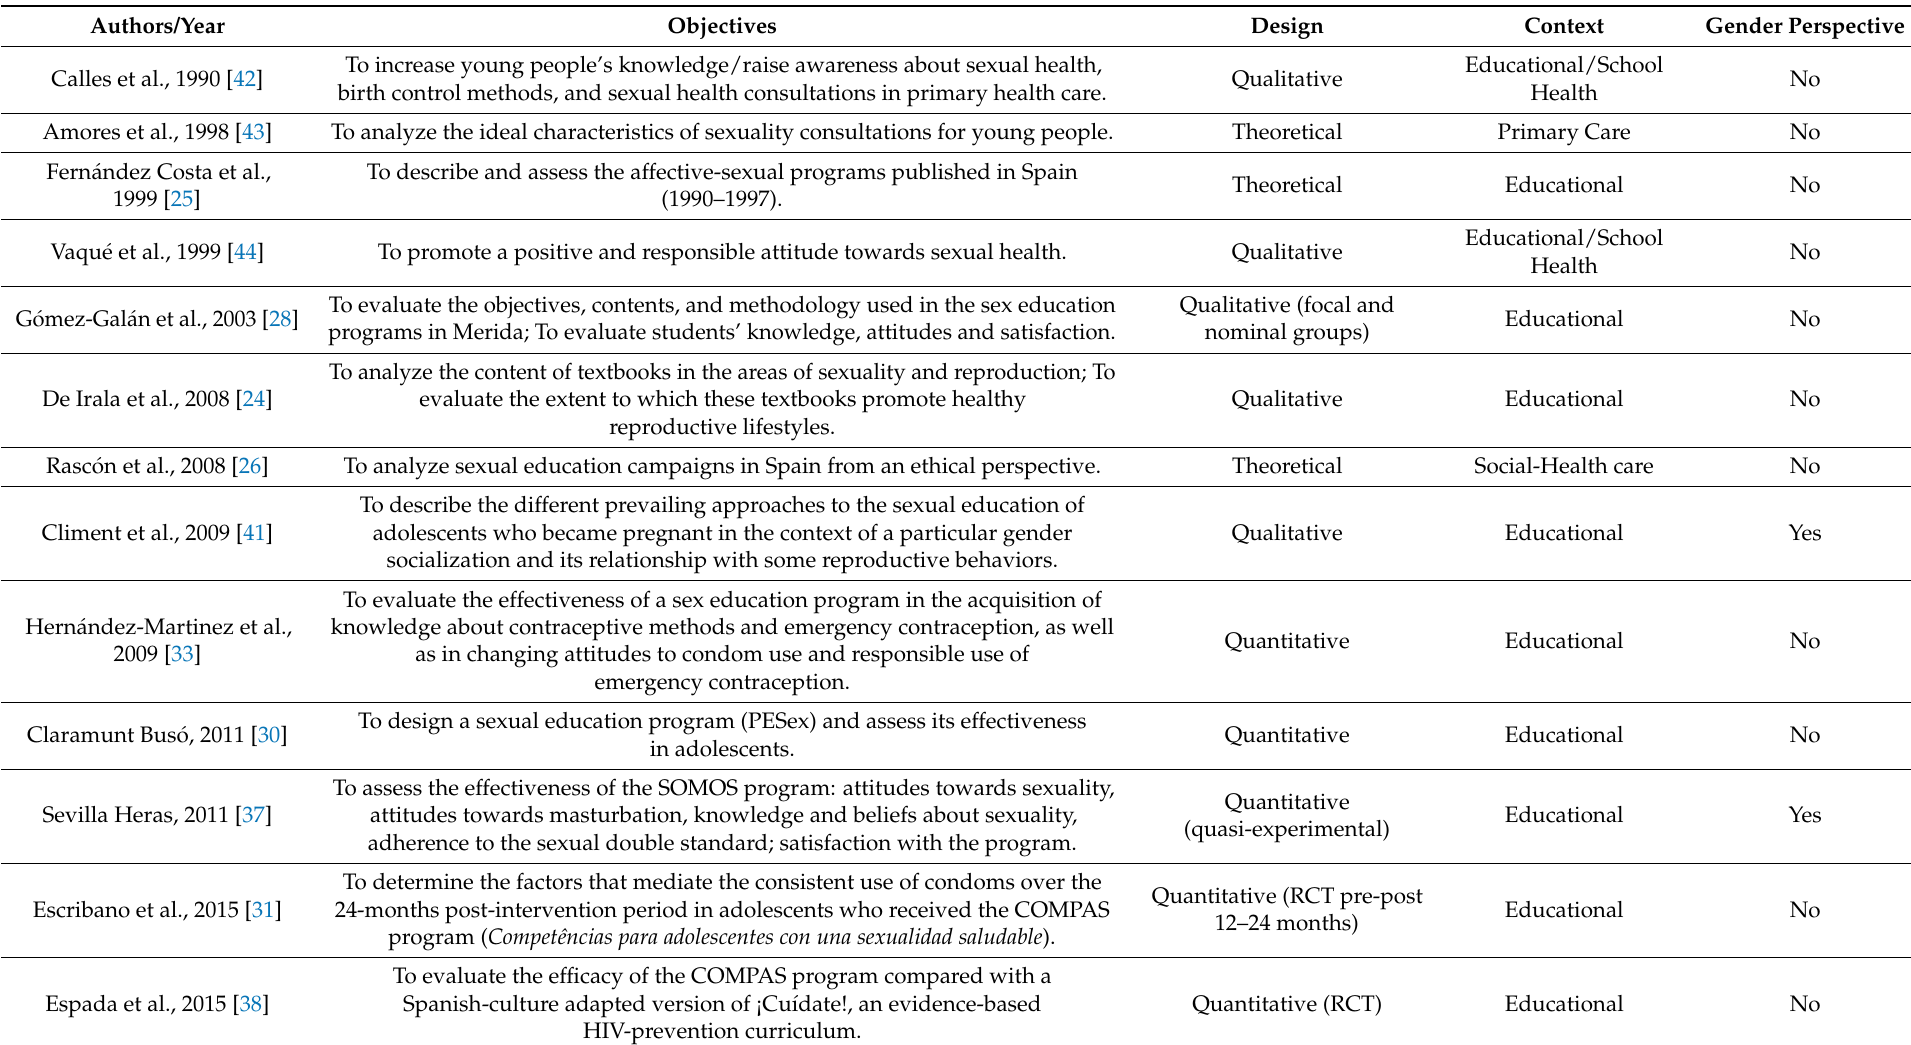
Table 1. Characteristics of the studies conducted in